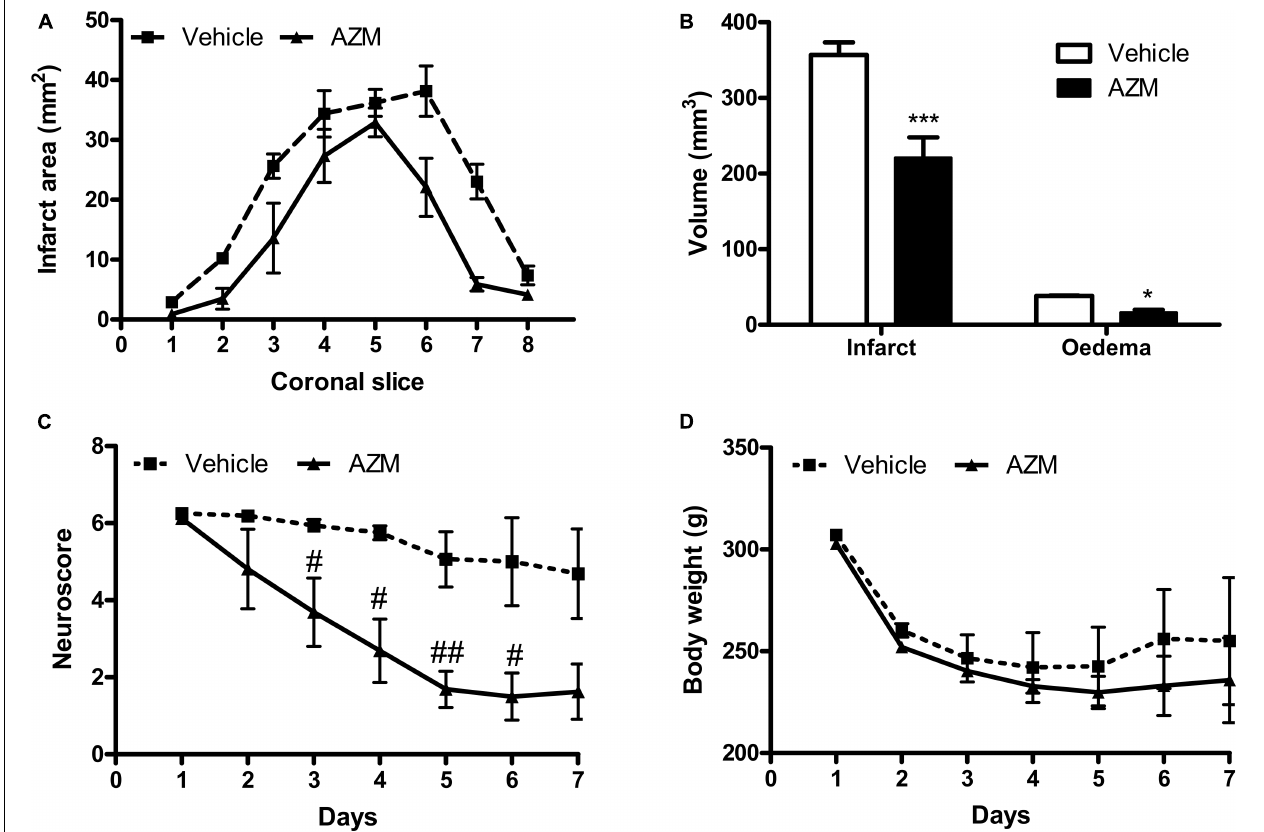
FIGURE 6 | Systemic administration of a single dose of azithromycin exerts neuroprotection up to 7 days after reperfusion in rats subjected to 2 h MCAo. (A) Ischemic area, (B) infarct and edema volumes, (C) neurological deficit and (D) body weight of rats subjected to 2 h MCAo followed by 7 days of reperfusion. Rats were injected i.p. with vehicle (0.9% NaCl) or azithromycin (AZM, 150 mg/kg) upon reperfusion. Data are expressed as mean ± SEM of four independent experiments ( n = 4 rats per experimental group); ∗∗∗ P < 0.001 and ∗ P < 0.05 vs. corresponding vehicle (two-way ANOVA followed by Bonferroni post hoc test); # P < 0.05 and ## P < 0.01 vs. corresponding vehicle (ANOVA for repeated measures followed by Bonferroni post-test).